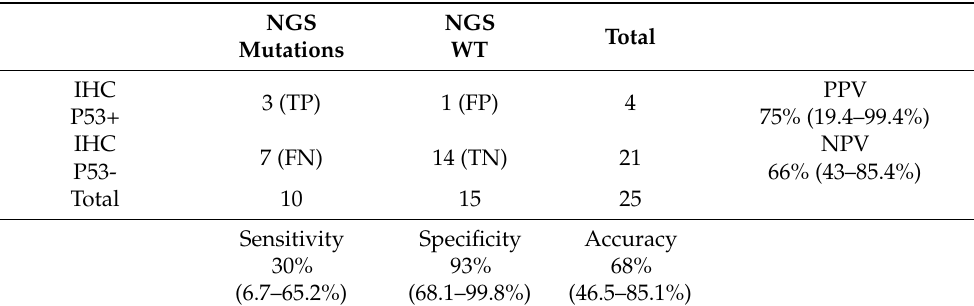
Table 4. Accuracy results and their 95% CI of TP53 genetic sequencing results versus p53 IHC staining results for ≥ 50% labelling